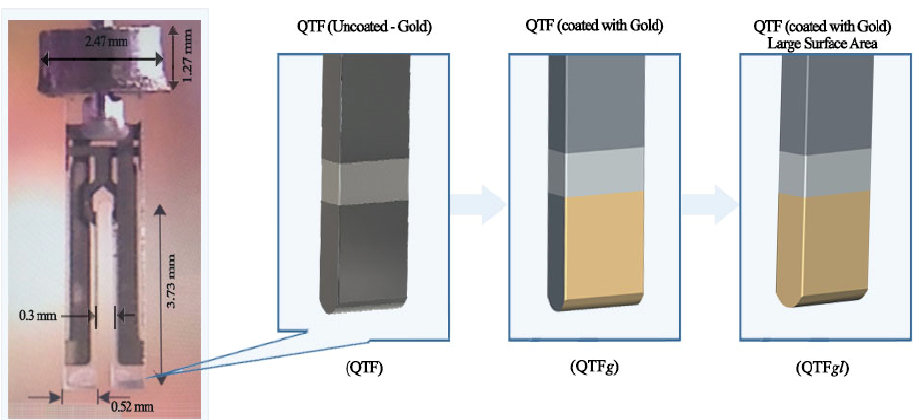
Figure 1. Schematic representation of QTF, QTF g , and QFT gl . Three QTF types were used in the experiment: gold-coated QTF (QTF g ), QTF coated with gold of larger surface area (QTF gl ), and uncoated QTF (QTF). QTF g was coated on the surface with gold at a thickness of 100 nm [23] by sputtering deposition, whereas QTF gl was coated with gold at a tilted area of QTF (Figure 1).